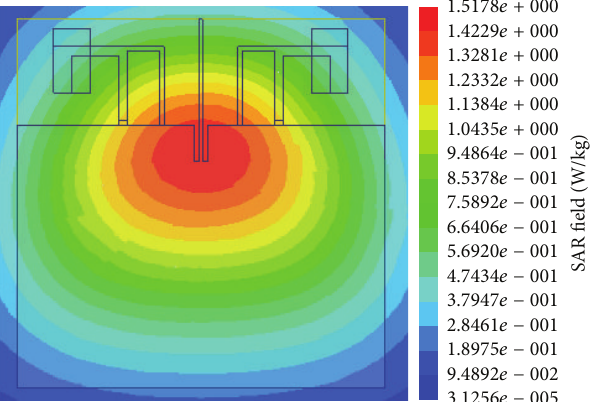
Figure 9: Simulated SAR distribution of the proposed antenna on the phantom at 2.4 GHz (input power: